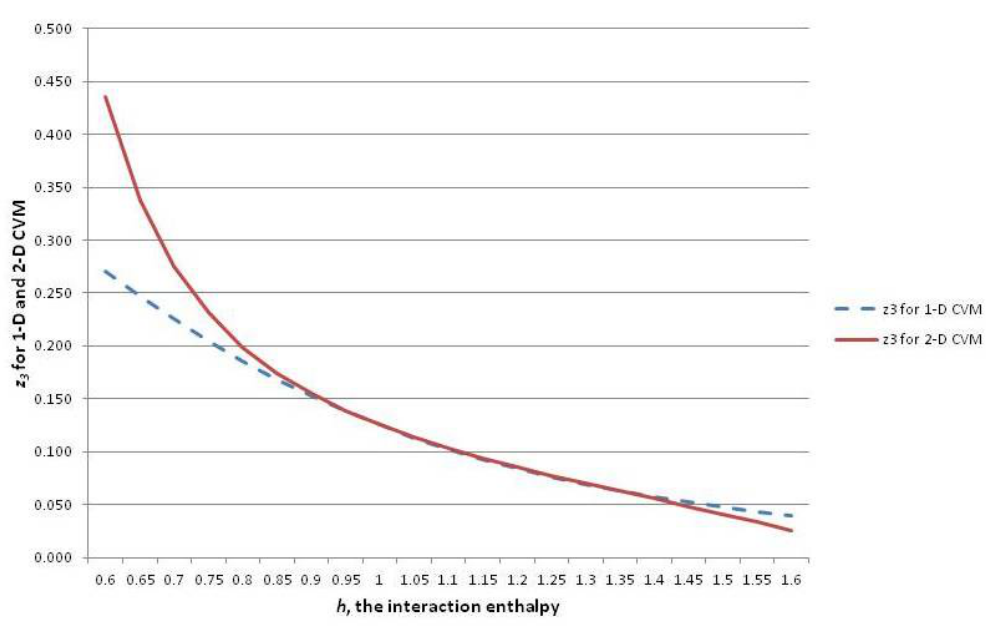
Figure 11. Comparison of configuration variable z 3 for the 1-D and 2-D CVM. Both values for z 3 are the expected 0.125 when h =